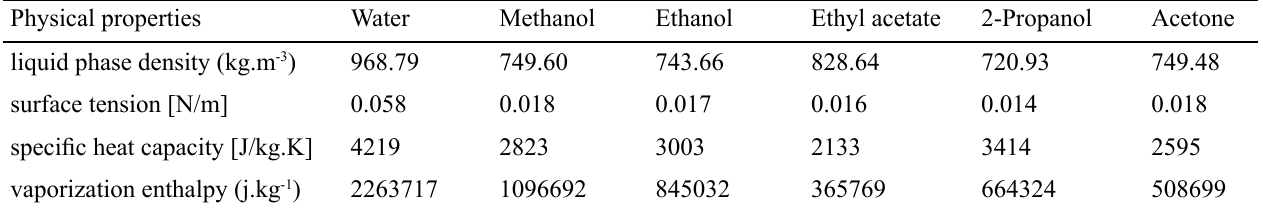
Table 3. Important physical properties of pure liquids.